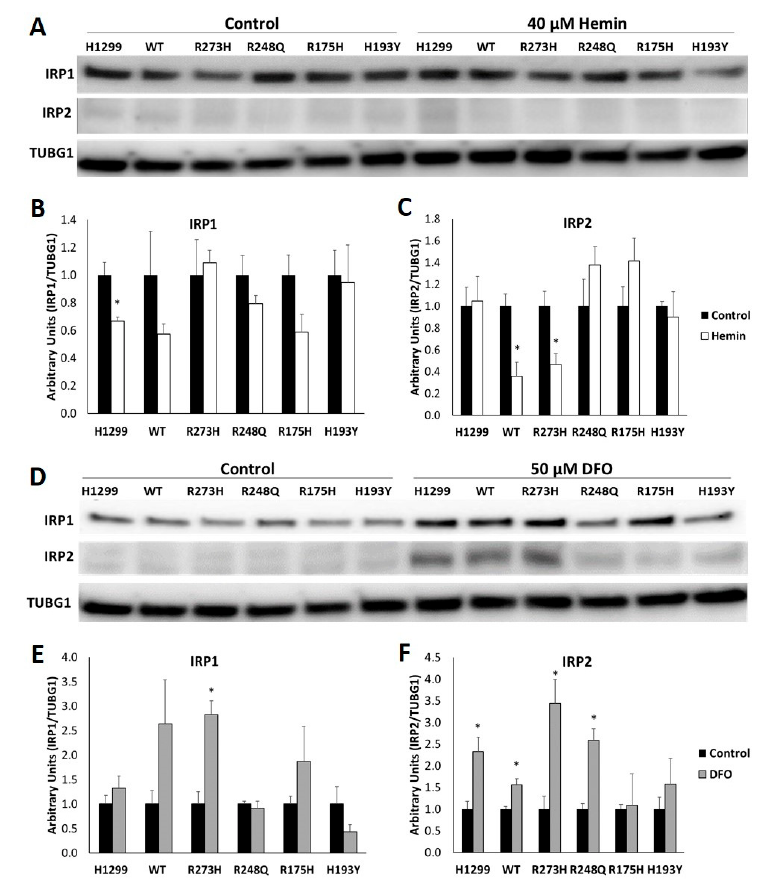
Figure 5. TP53 expression influences the iron-dependent regulation of IRP1 and IRP2 protein expression. Representative Western blots of IRP1 and IRP2 protein expression in TP53 null H1299 cells (H1299) or following the induction of the indicated TP53 subtype and treatment with 40 μ M hemin ( A ) or 50 μ M DFO ( D ) for 24 h. Relative expression levels were quantitated following normalization to anti-gamma-tubulin (TUBG1) as the loading control ( B , C , E , F ). * Denotes statistical difference from respective controls, p < 0.05.